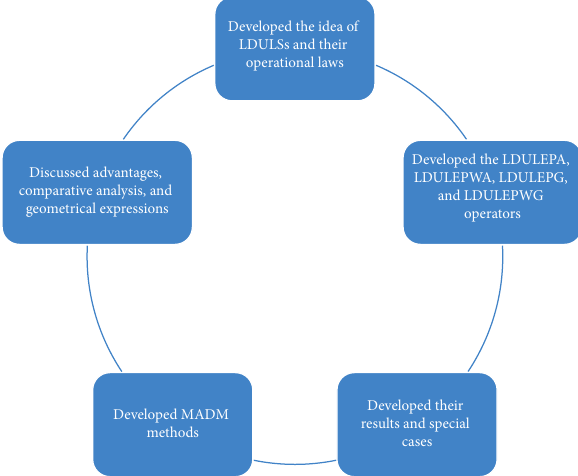
Figure 1: Geometrical expressions of the explored